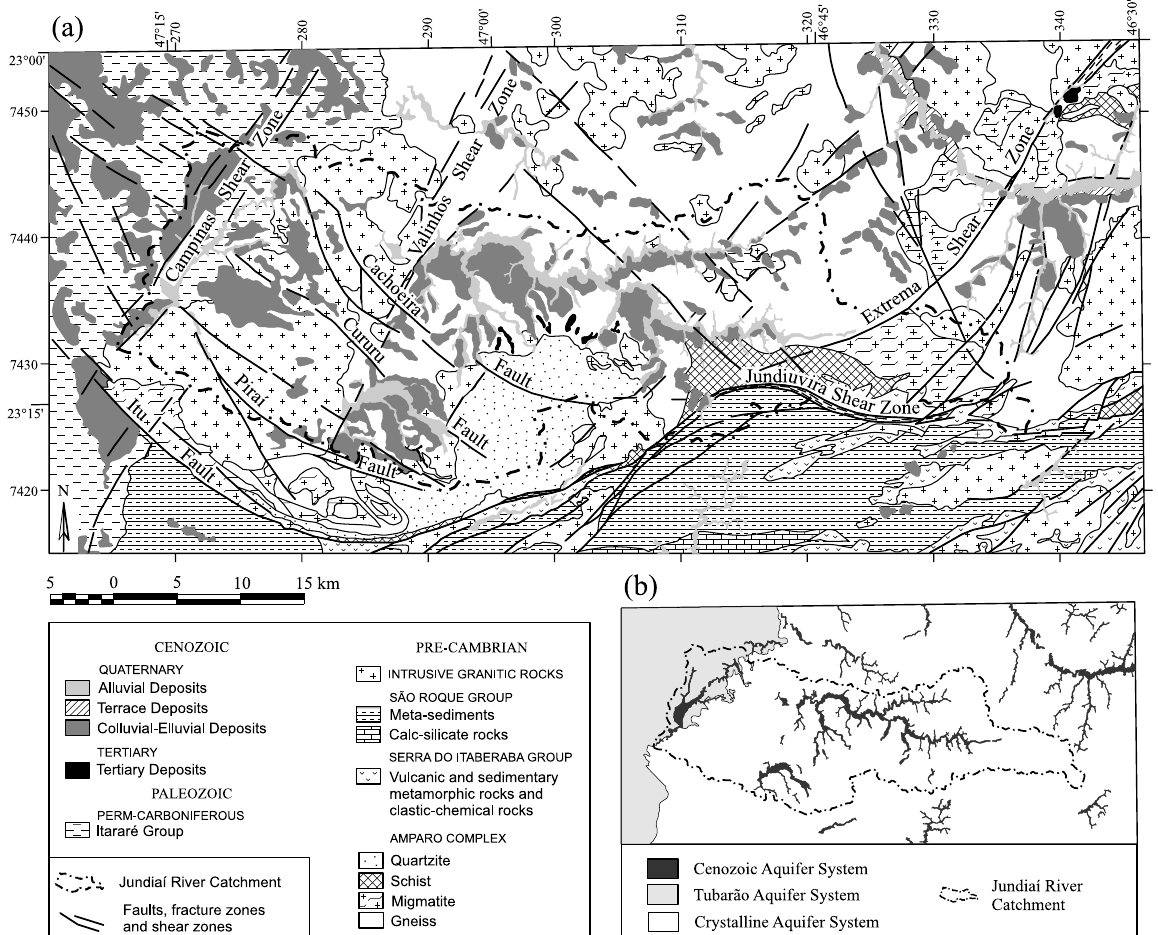
Fig. 2 – (a) Geologic map and (b) hydrogeologic map of the Jundiaí River